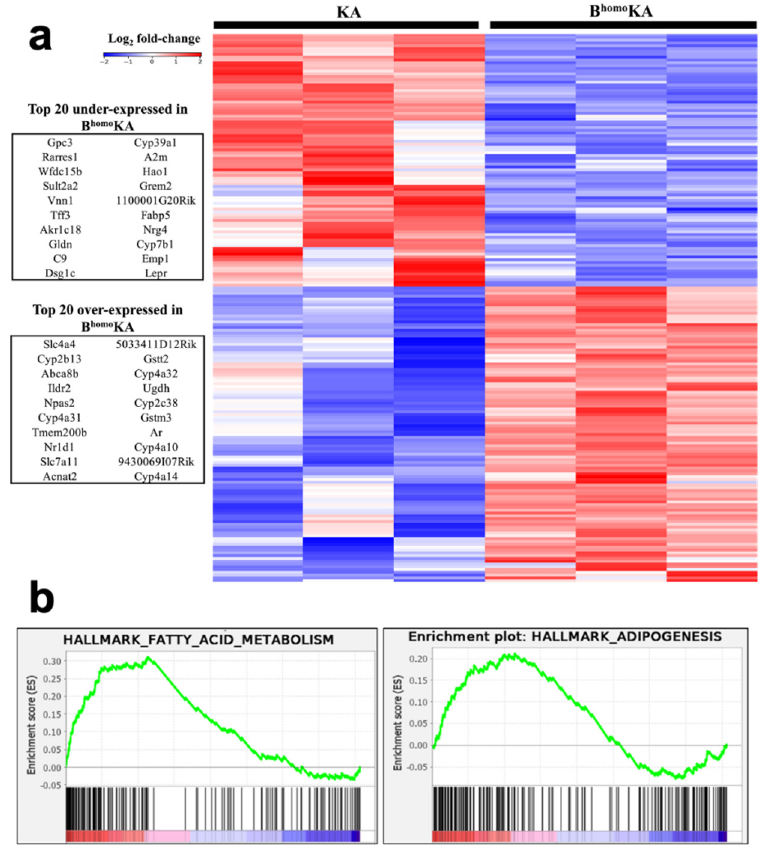
Figure 3. Hepatic tumors from KA and B homo KA experimental GEMM cohorts have unique gene expression patterns. ( a ) KA and B homo KA liver lesions have differential gene expression by Affymetrix microarray. Supervised clustering heatmap of Affymetrix microarray data (3 KA samples versus 3 B homo KA samples, log 2 fold change >2, p < 0.05). The top 20 under- and overexpressed genes in the B homo KA cohort are pictured to the left of the heatmap; ( b ) Gene set enrichment analysis (GSEA) of differentially expressed transcripts in microarray of KA and B homo KA hepatic tumors show positive enrichment in hallmark gene signatures for fatty acid metabolism and adipogenesis .